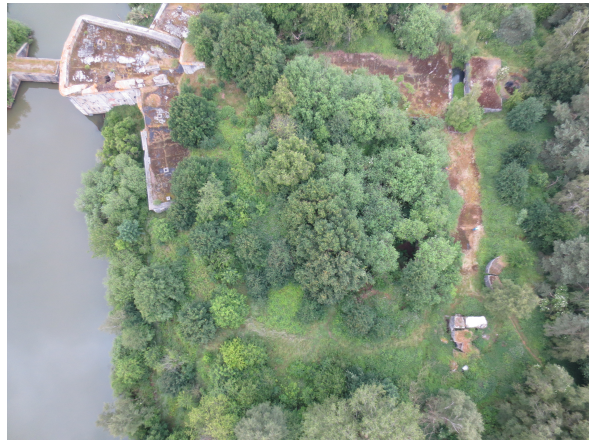
Figure 1. Single image of the Fort Broechem site